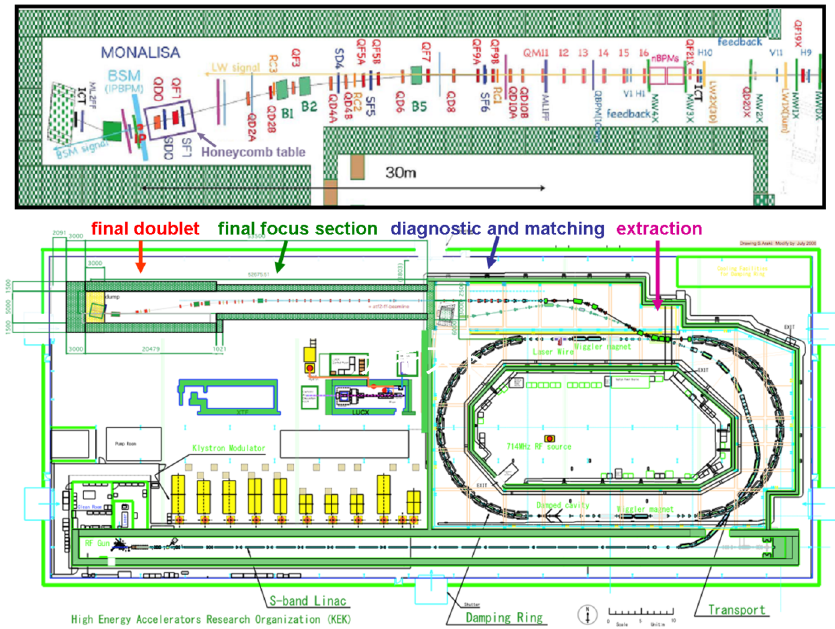
FIG. 1. (Color) Layout of the ATF/ATF2 facility. The second half of the ATF2 beam line is shown in more detail in the upper part of the